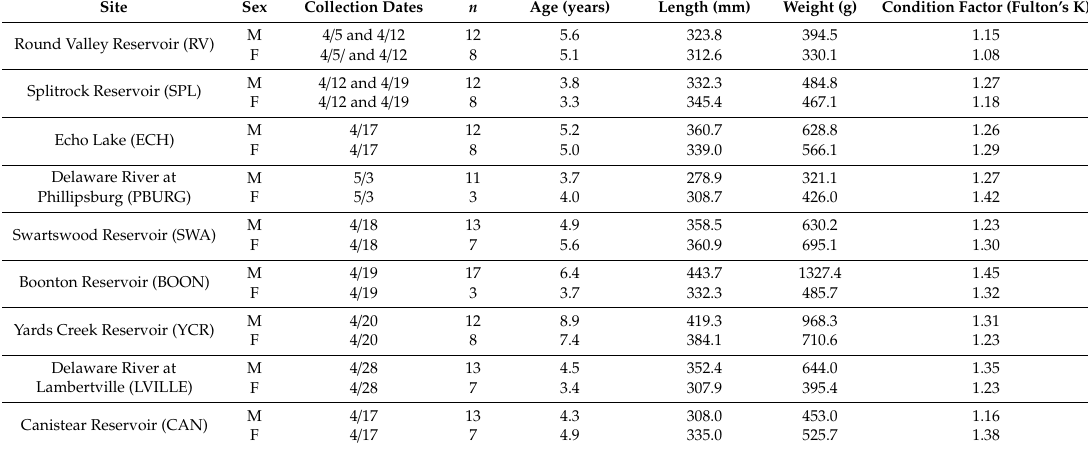
Table 1. Sex-sorted morphometric data (averages) for smallmouth bass collected from New Jersey waters during